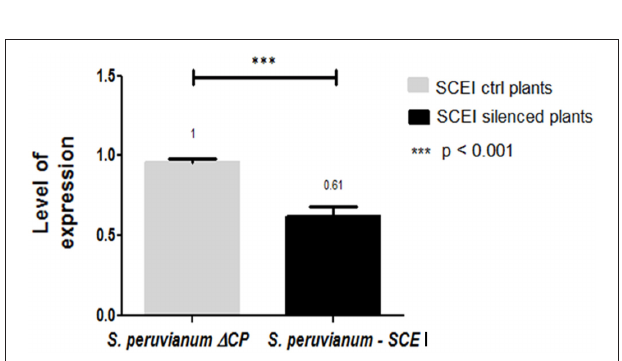
FIGURE 3 | Expression level of the SCE I gene in S. peruvianum plants after silencing with ToMoV – VIGS vector. Real Time one step RT-PCR amplifications were performed using 100ng of total RNA with the iScript TM One-Step RT-PCR kit using SYBER ® Green. Quantification was based on the cycle threshold value with the expression level of SCE I normalized to that of S. peruvianum